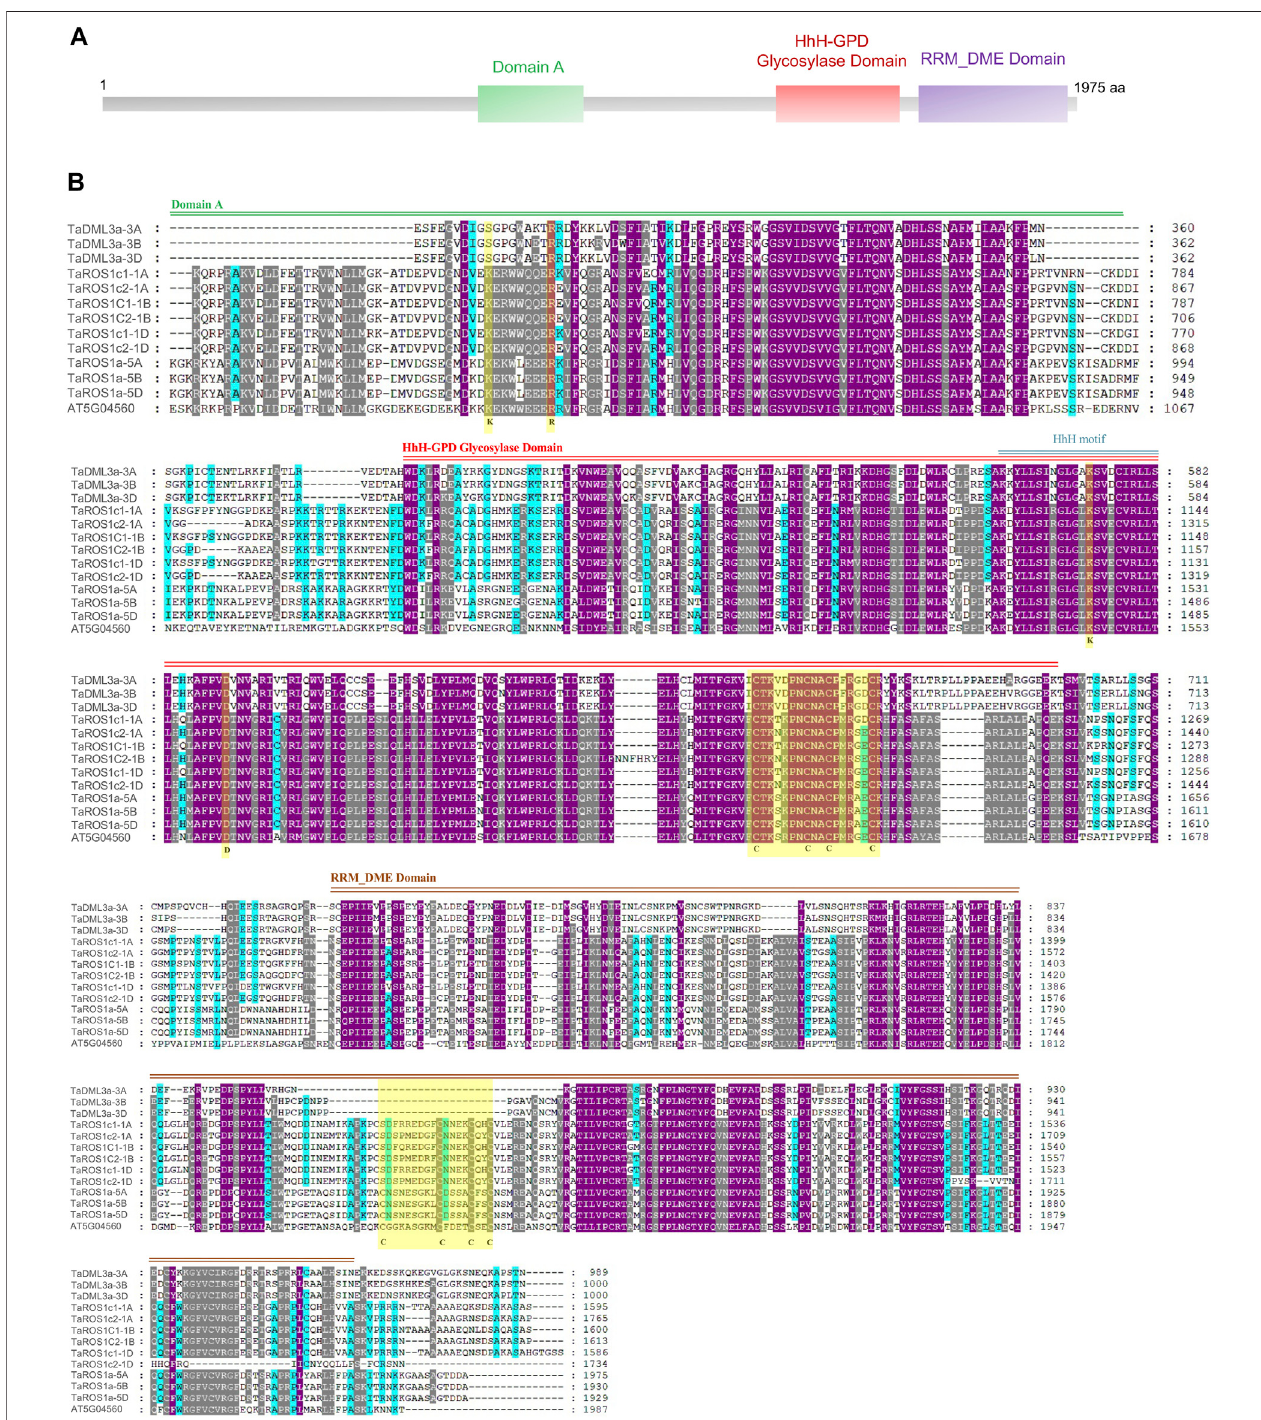
FIGURE 3 | Conserved domain composition and multiple sequence alignments of the conserved domain sequences of TaDMTase proteins. (A) Three different conserved domains (Domain A, HhH-GPD glycosylase domain and RRM_DME domain) are shown in different colored boxes. (B) Multiple sequence alignment analysis oftheconserveddomainsequencesof12wheatdMTaseproteinsequencesandanArabidopsisdMTaseprotein.Thekeyconserveddomainsarehighlightedbydouble lines(DomainAbygreencolor,HhH-GPDglycosylasedomainbyredcolorandRRM_DMEdomain bybrowncolor)andthedomainnamesareshownat thetopof the sequence. Gene names are shown on the